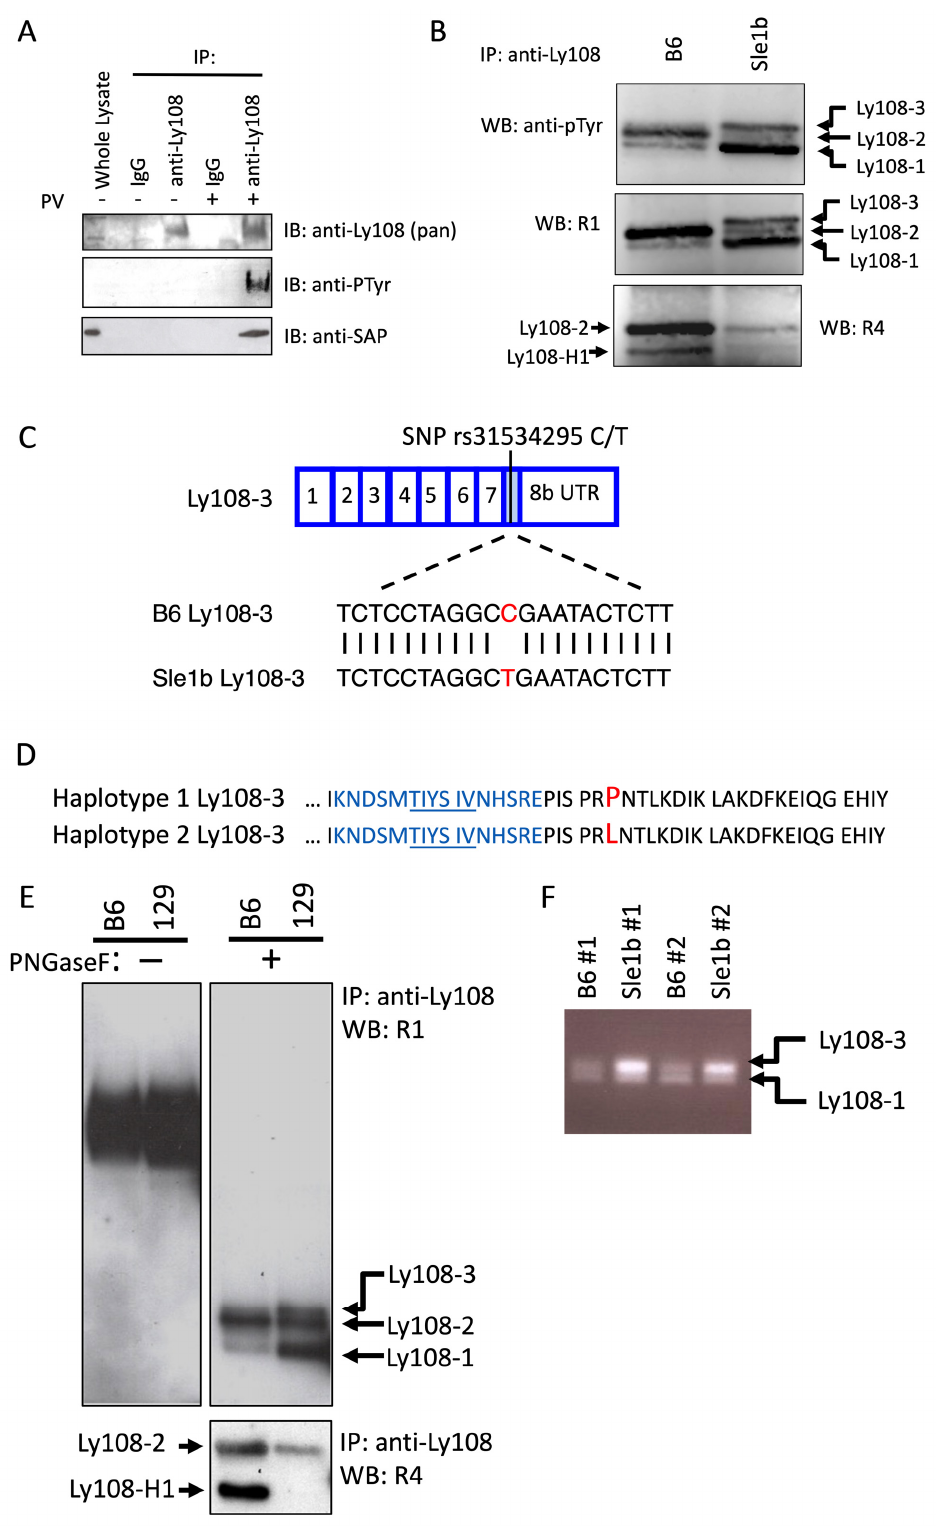
Figure 4. Ly108 isoforms, including Ly108-3, are differentially expressed, and phosphorylated in primary cells. ( A ) Suspended thymocytes from B6 mice were treated where indicated for 20 min with pervanadate (PV+) before lysis, after which immunoprecipitation was performed with the indicated antibodies or isotype control (IgG). After SDS-PAGE and transfer, membranes were blotted for Ly108 and SAP. Phosphorylated Ly108 was detected on stripped membranes that were re-probed with anti-phosphotyrosine. ( B ) Thymocytes from the indicated strains were treated with